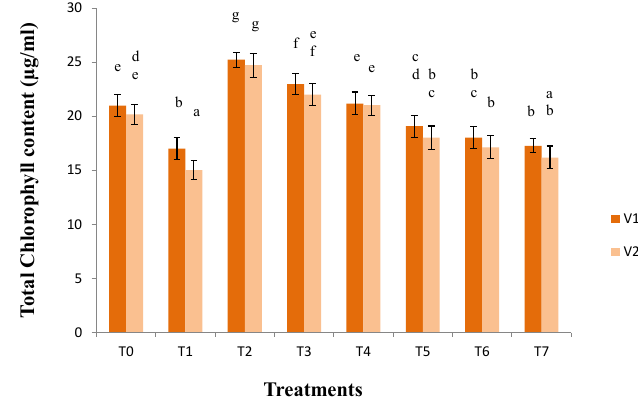
Fig. 2B: Effect of Azospirillum inoculation on total chlorophyll content of two canola varieties(v1 and v2) grown under drought stress. Where, To = Un-inoculated and well watered, T = Un-inoculated and drought exposed, T2 = Seed inoculated and well watered, T3 = Rhizosphere inoculated and well watered, T4 = Seed inoculated with heat killed inoculums and well watered, T5 = Seed inoculated and drought exposed, T6 = Rhizosphere inoculated and drought ex- posed, T7 = Seed inoculated with heat killed inoculums and drought exposed. And V1 = Rainbow, V2 = Con II.